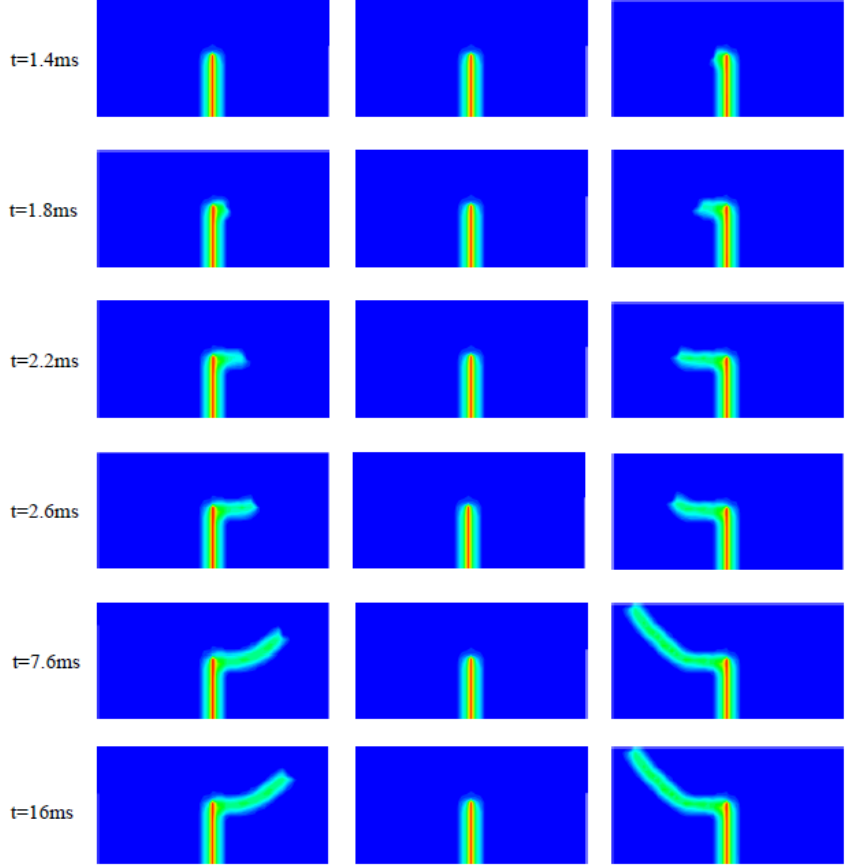
Figure 14. Crack propagation of asphalt pavement under the action of wheel friction is considered. ( a ) Vehicle load approaching the crack without friction; ( b ) vehicle load approaching the crack with friction; ( c ) vehicle load away from the crack with friction.